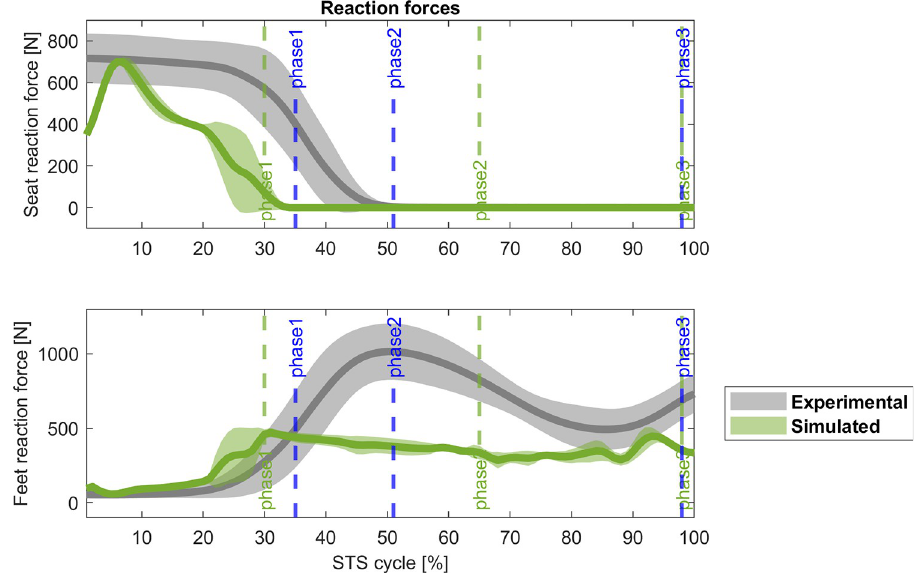
Fig 6. Comparison (mean ± std) of the reaction forces [N for the 4-phases controller. Grey: experimental data, green: simulated data; blue vertical lines: experimental cycle times; green vertical lines: 4-phases controller cycle times. r Fseat = 0.86, Δ = -3%; r Fground = 0.91, Δ = 0%.